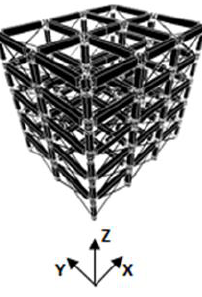
Figure 5. Numerical model of the infilled framed structure.